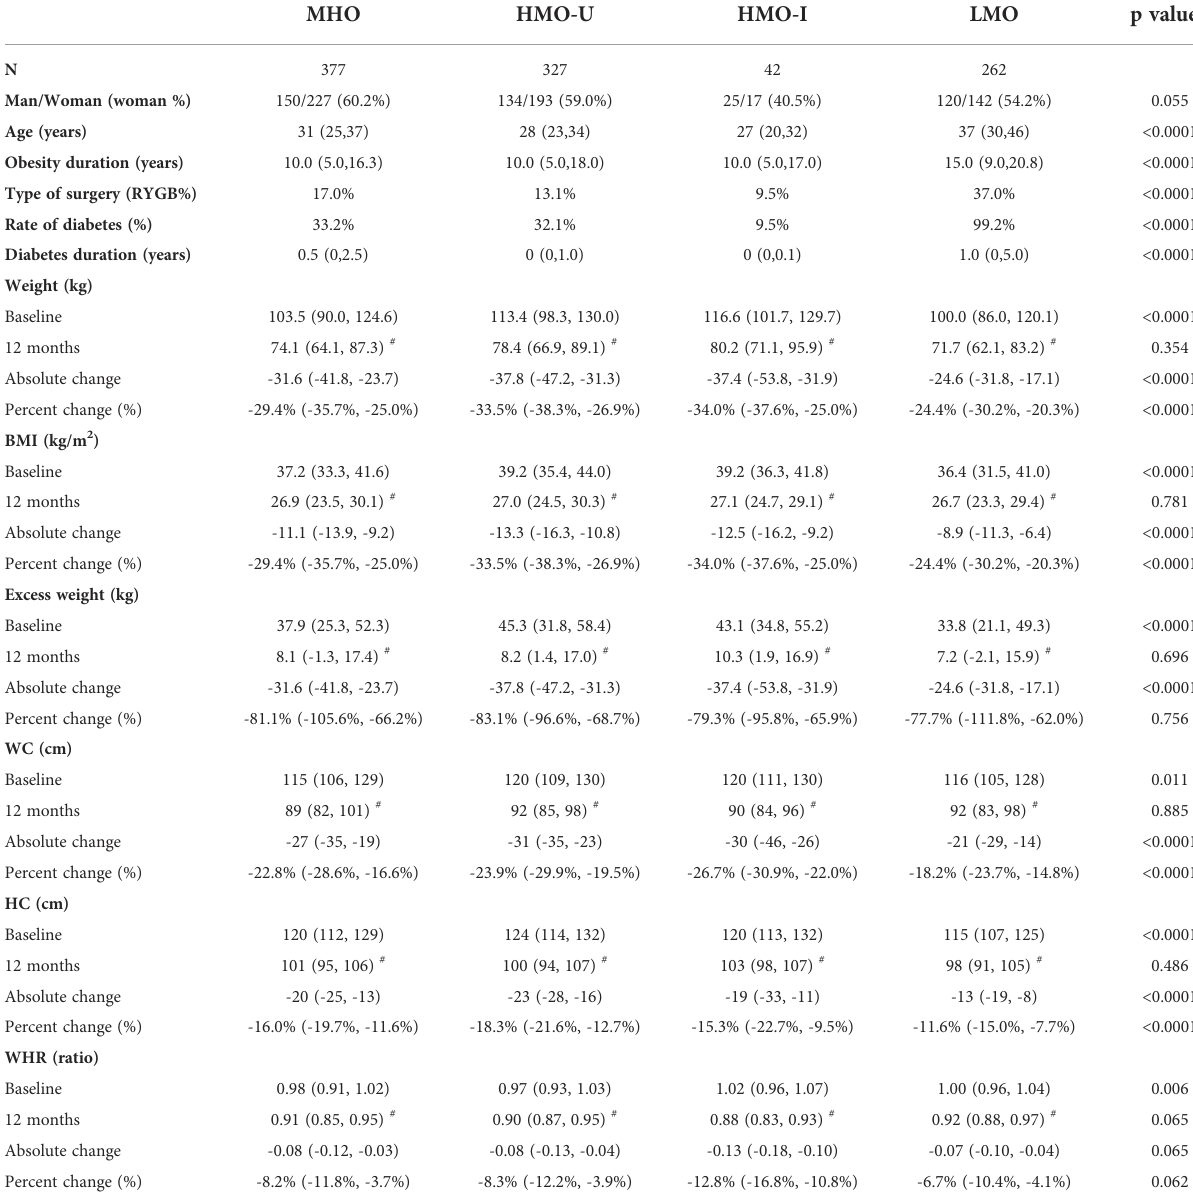
TABLE 1 The anthropometry characteristics of the four AIM subgroups of obesity patients at baseline and 12-month post-surgery. MHO HMO-U HMO-I LMO p value &